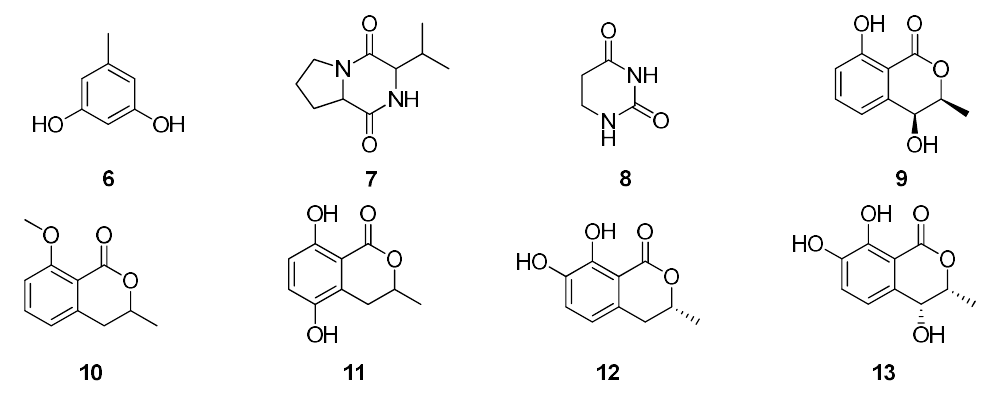
Figure 4. Compounds extracted from Penicillium species .